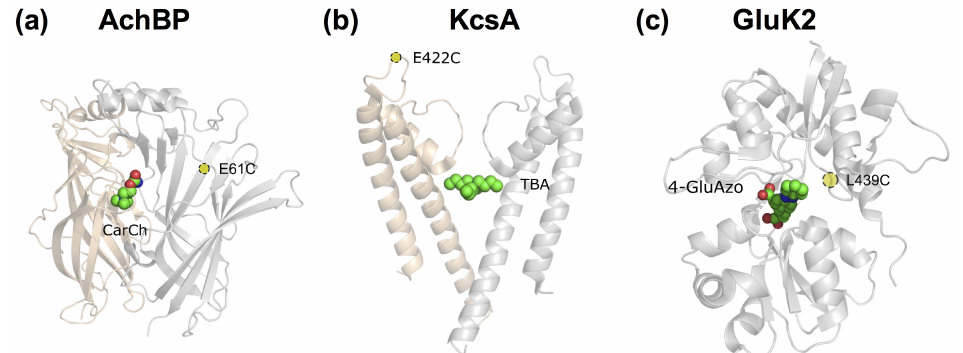
Figure 2. Crystallographic structures used for rational structure-based design of photoswitchable ligands ( a , b ) or its validation ( c ). ( a ) Structure of the acetylcholine binding protein (AchBP) bound to carbamylcholine (CarCh), PDB code 1UV6 [15]. ( b ) Structure of the KcsA potassium channel with the pore blocker tetrabutylammonium (TBA) bound in the intracellular site below the selectivity filter, PDB code 2BOB [18]. ( c ) Structure of the ligand binding domain (LBD) of the kainate receptor GluK2 in complex with 4-glutamyl-azobenzene (4-GluAzo), PDB code 4H8I [19]. For the sake of clarity, only one or two subunits of the oligomeric proteins are shown in cartoon representation and colored either in gray or apricot. Ligands are displayed in space-filling representation, with C, O and N atoms colored in green, red and blue, respectively. The position of the cysteine residue serving as covalent attachment point for the PTL is highlighted with a yellow